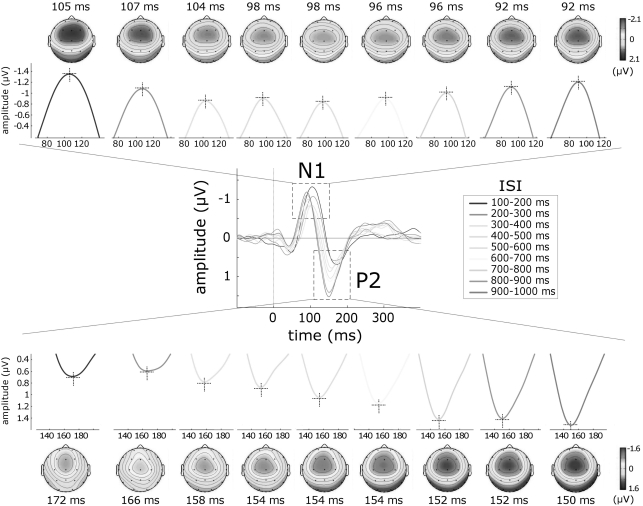
Effect of inter-stimulus interval (ISI) on the auditory N1 and P2 waves.Trials were classified according to ISI, yielding nine categories ranging from 100 to 1000 ms in steps of 100 ms. At short ISIs, the brain activity elicited by two consecutive stimuli was likely to overlap and therefore distort the obtained ERP waveform. This distortion was corrected using the Adjacent Response procedure [35] (see Methods). The middle panel displays the auditory ERP obtained at each ISI category (group-level average; Cz vs. average reference). Each ISI category is colour coded. x axis, time (ms); y axis, amplitude (µV). Upper and lower panels display the N1 and P2 waves and their scalp distributions, separately for each ISI. Note the opposite effect of ISI on the amplitude of the auditory N1 and P2 waves: at very short ISIs, the N1 displays significantly larger amplitudes, while the P2 displays significantly smaller amplitudes.